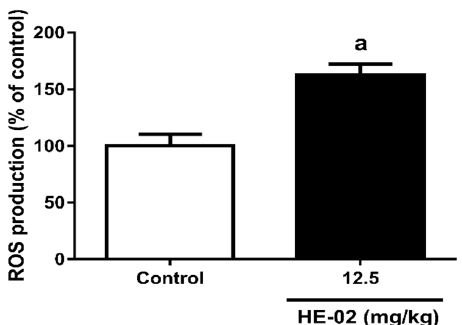
Figure 5. Reactive Oxygen Species (ROS) production (% of control) after treatment with HE-02 (12.5 mg/kg). Data presented as mean ± SEM of six animals analyzed in pairs by Mann–Whitney Test. a p < 0.05 compared to the control group.